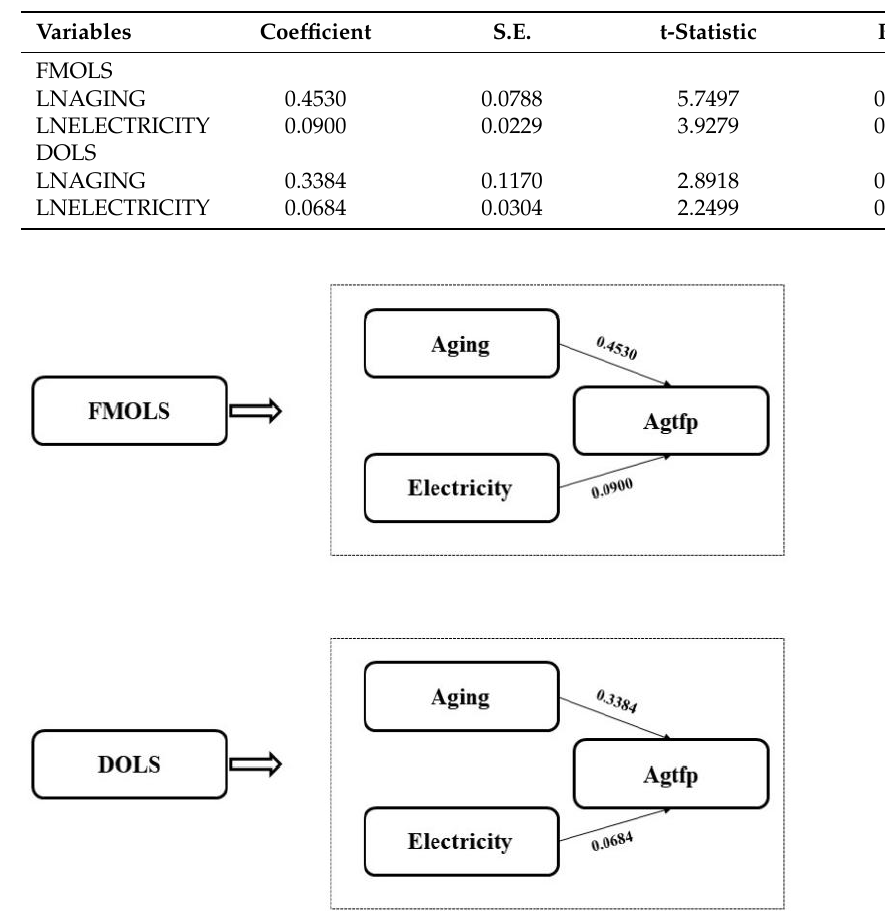
Table 5. Benchmark results.